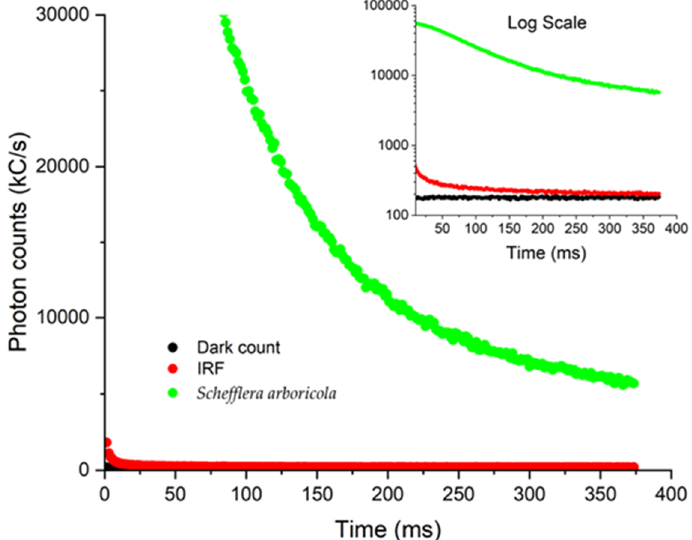
Figure 6. Photon vs. time curves plotted for the dark counts (black), the background blank including the IRF (red), and a sample delayed fluorescence response curve from Schefflera arboricola leaf (green). Inset is the log plot.